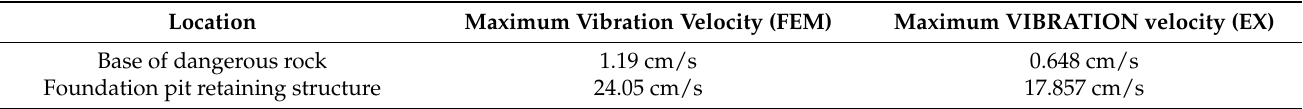
Table 9. Comparison between experiment and